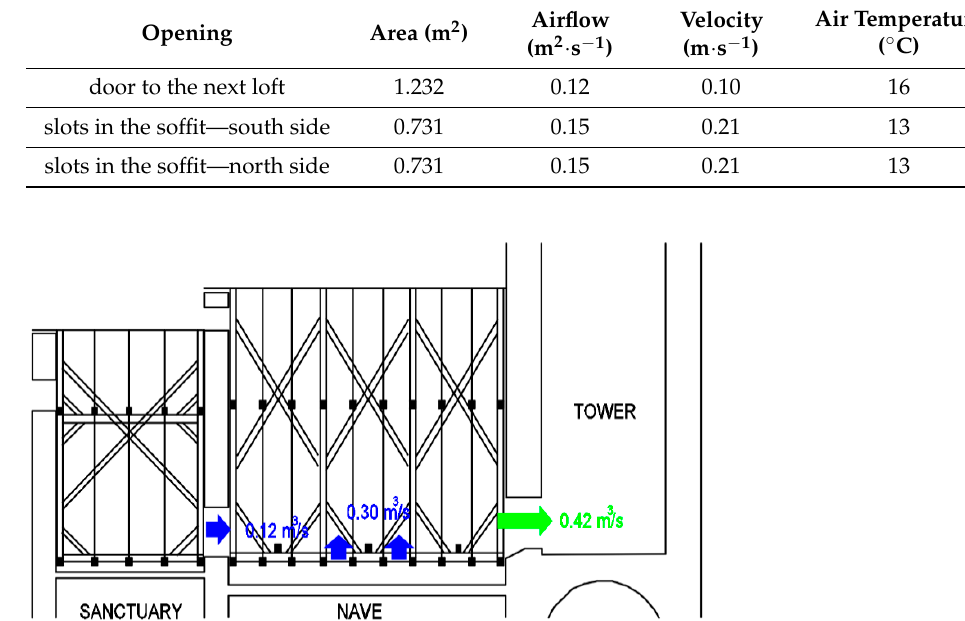
Figure 16. Airflow paths at 2:00 a.m. obtained from BPS simulation.